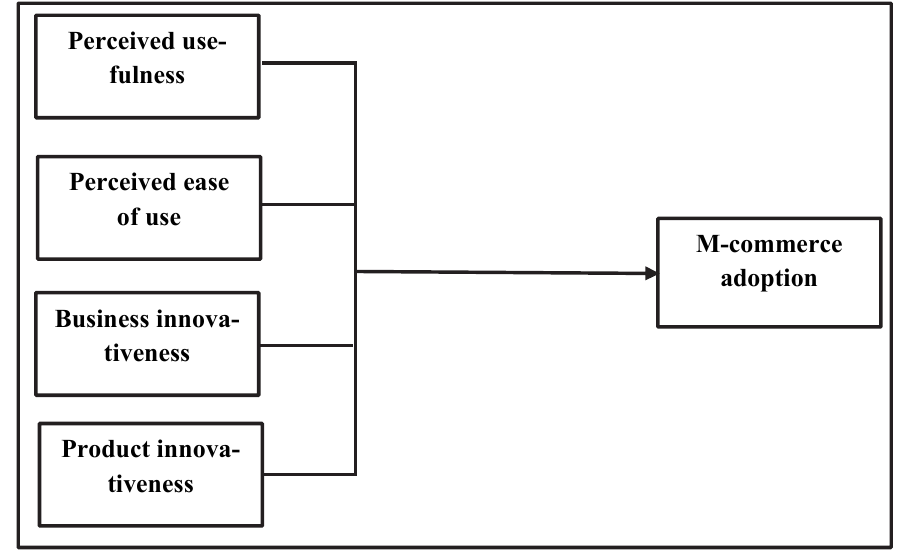
Fig. 1. Conceptual